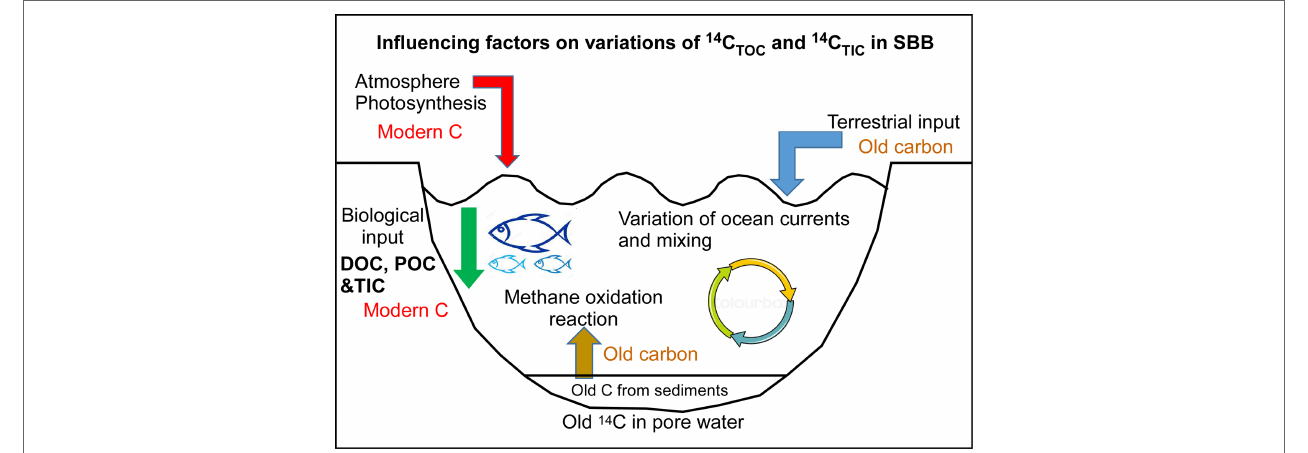
FIGURE 7 | A conceptual box model of the influencing factors on the carbon cycles in Santa Barbara